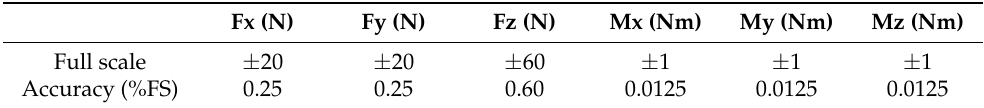
Table 1. Balance characteristics.